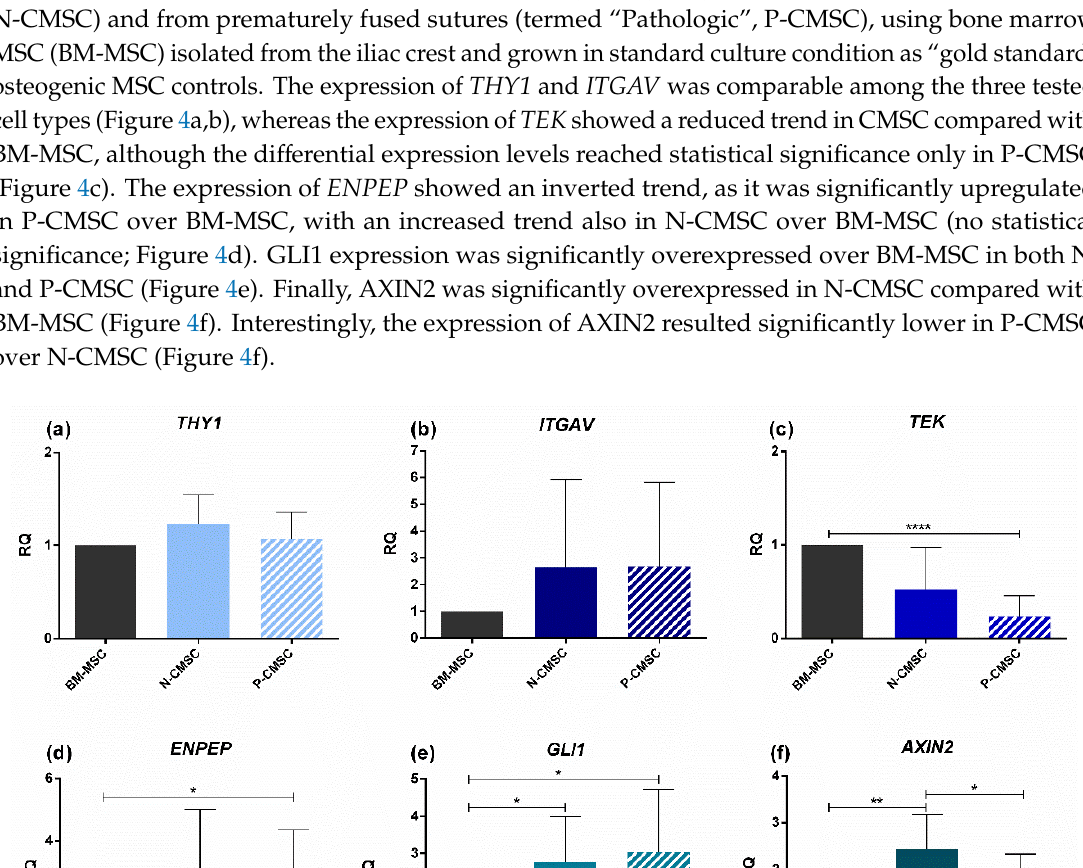
Figure 5. Expression profiles of osteo-specific genes. Transcript levels of: ( a , f ) RUNX2 ; ( b , g ) ALP ; ( c , h ) ON ; ( d , i ) OPN ; and ( e , j ) OCN , evaluated by qPCR in N-CMSC and P-CMSC, respectively, cultured with osteogenic medium (OM) for one (1 wk) and three weeks (3 wk). Cells cultured in standard growth medium (GM) were tested as controls at each time point. RQ, Relative Quantity (see Methods for details). * p < 0.05; ** p < 0.01; **** p < 0.0001.